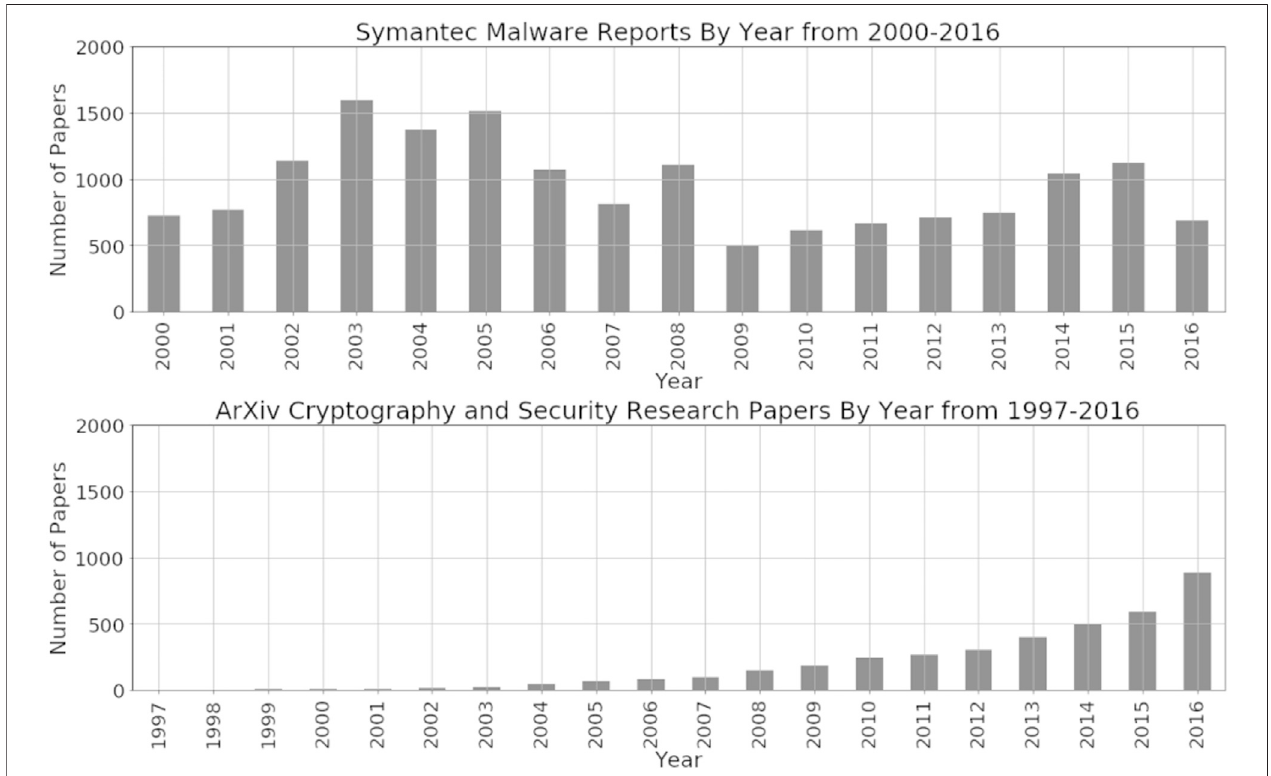
FIGURE 4 | Symantec malware reports from 2000 to 2017 data distribution by year (top) and Cryptography and Security arXiv articles from 1997 – 2016 data distribution by year (bottom) .